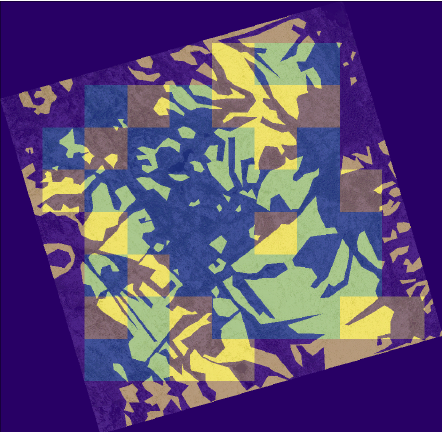
Figure 9. Example of training/testing splits for ELD: yellow squares–testing dataset (35%), blue rectangles–training dataset